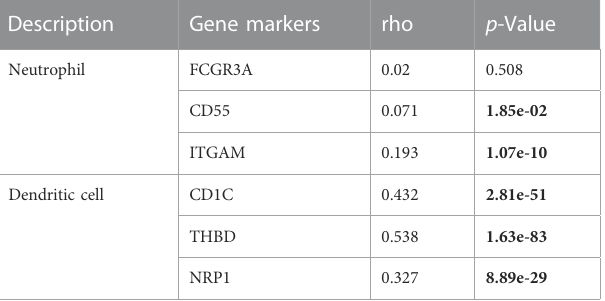
TABLE 2 ( Continued ) Correlation analysis between KLF2 and immune cell marker gene in TIMER